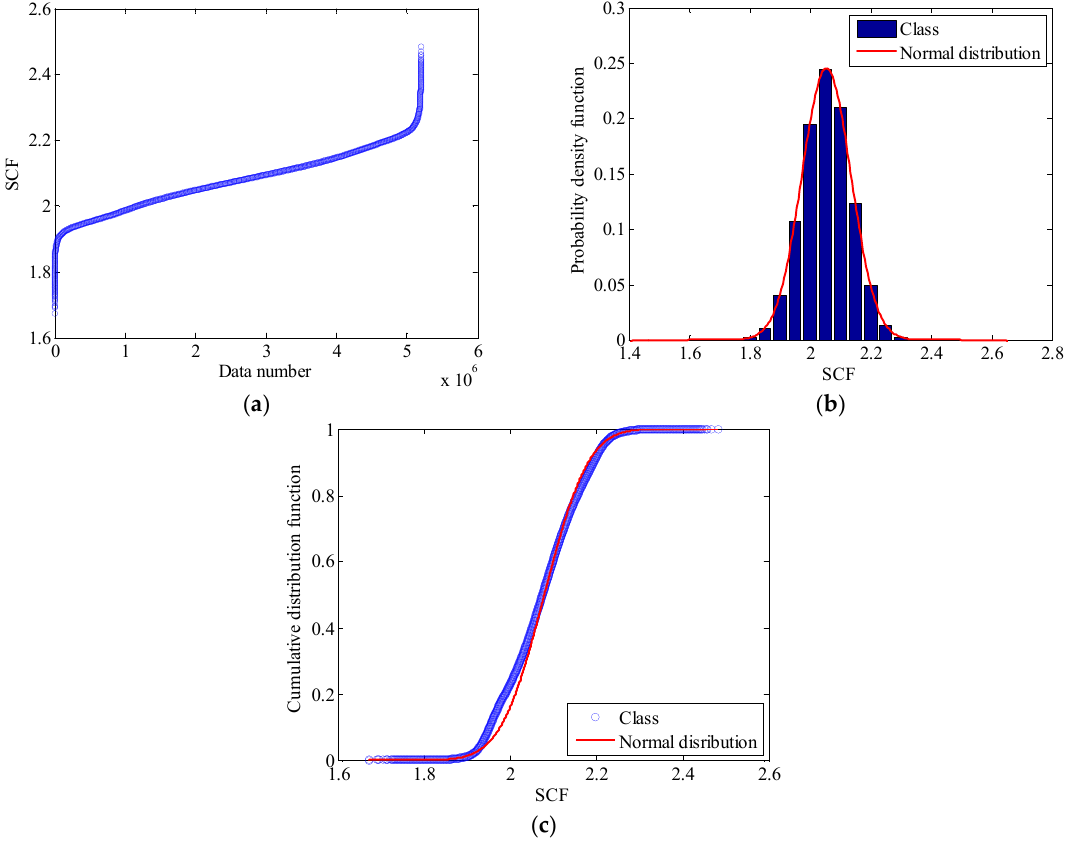
Figure 12. Stochastic property of SCF: ( a ) SCF data in an ascending order; ( b ) PDF of SCF; ( c ) CDF of SCF. Table 2. Statistical properties of